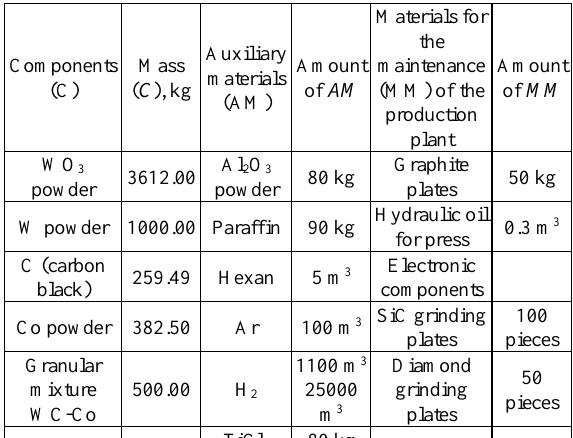
Table 1. Components and their amounts for production of 5000 kg WC-Co